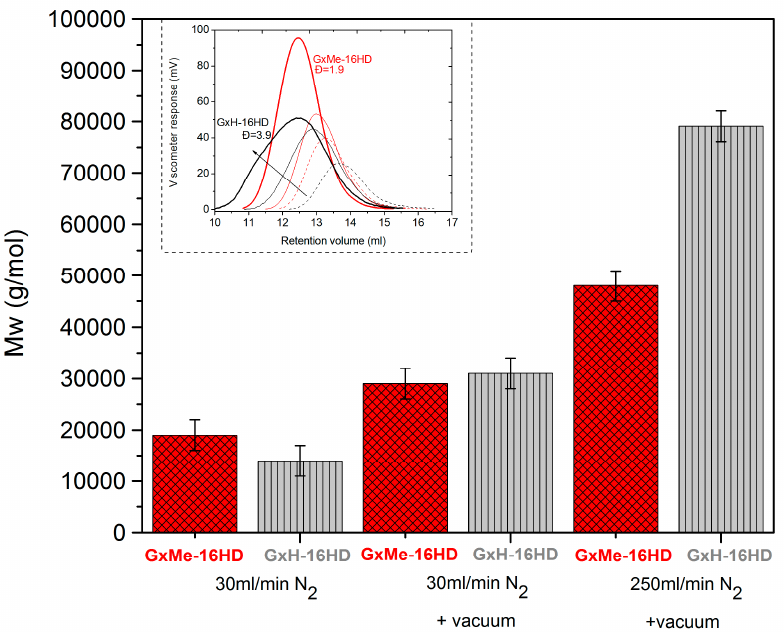
Figure 3. M w values comparison and GPC distribution curves (in the insert) of GxMe-16HD and GxH- 16HD after 3.5 h under 30 mL/min N 2 (dot line); after 3.5 h under 30 mL/min N 2 + 0.5 h at 10 − 2 mbar (solid line); after 3.5 h under 250 mL/min N 2 + 0.5 h at 10 − 2 mbar (bold solid line). Error bars are taken here as minimum and maximum value (samples were made in